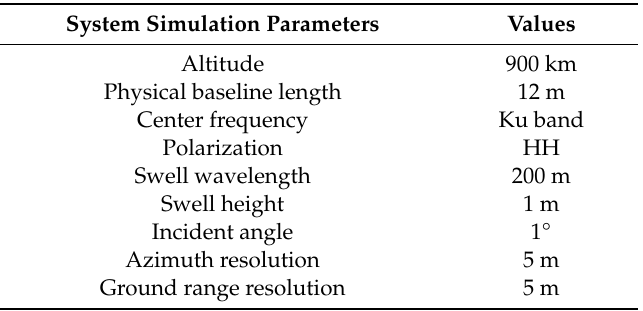
Table 1. System simulation parameters.